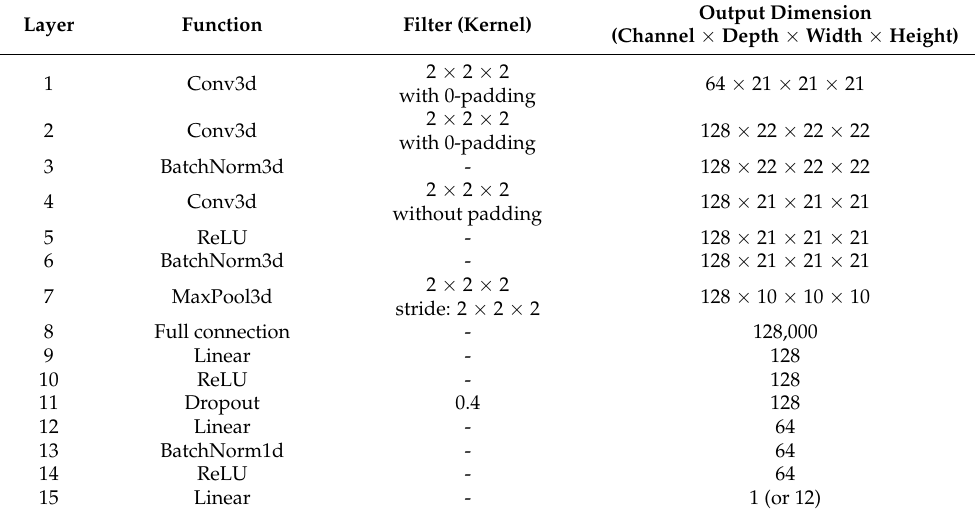
Table 1. The layers and parameters of the CNN model used in this study.